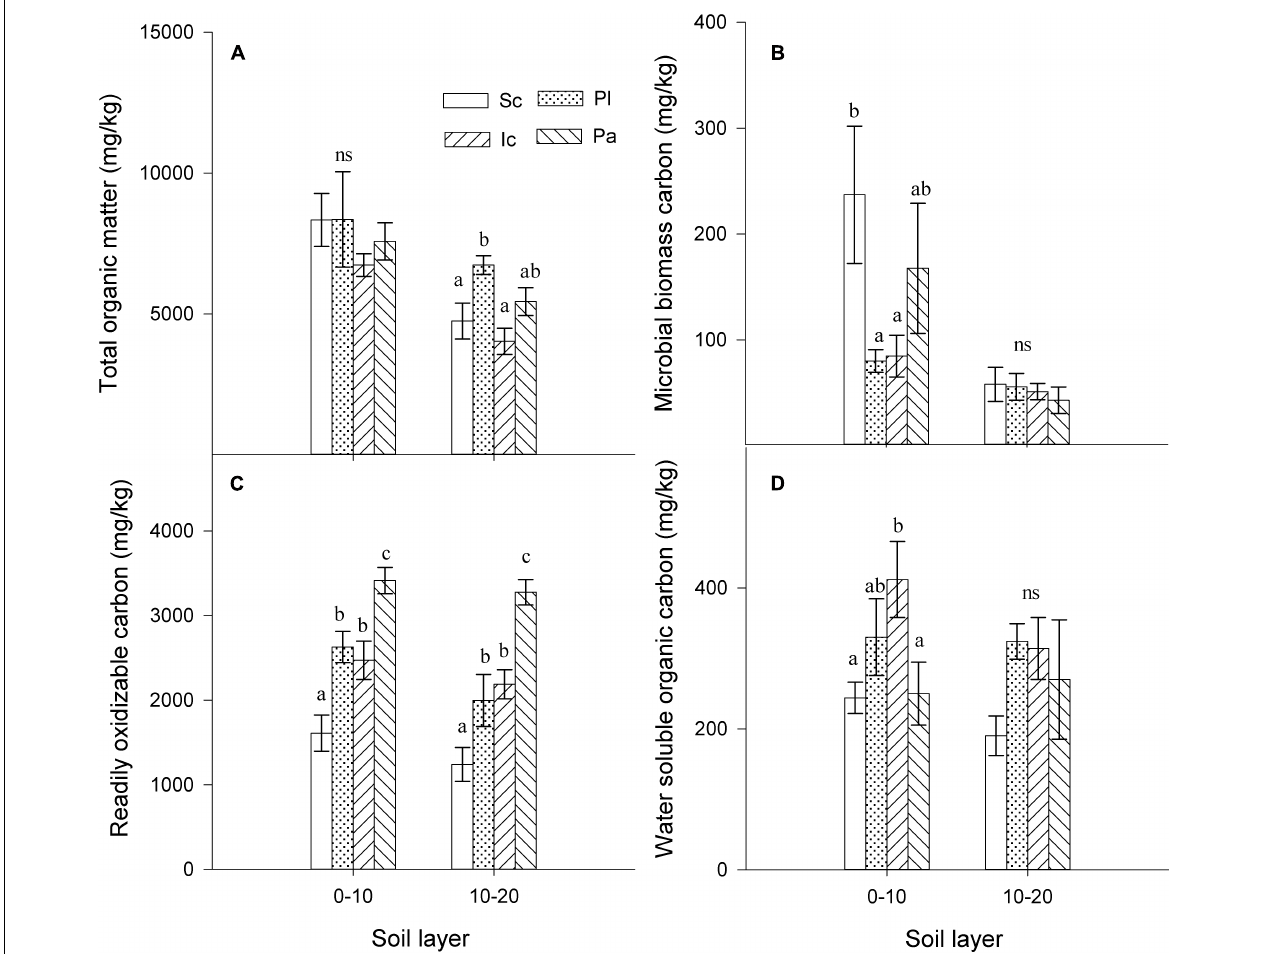
FIGURE 1 | Soil organic matter content in the soils from different species. (A) total soil organic matter (TSOM), (B) microbial biomass carbon (MBC), (C) readily oxidizable carbon (ROC), and (D) water soluble organic carbon (WSOC). Sc, S. canadensis ; Pl, P. latifolius ; Ic, I. cylindrical ; Pa, P. australis ). Soils are sample from two layers (0–10 cm and 10–20 cm). Bars are means ± standard error. Different letters indicate significant differences between the species for the parameters within the same soil layer ( P < 0.05). ns, non-significant, P > 0.05.